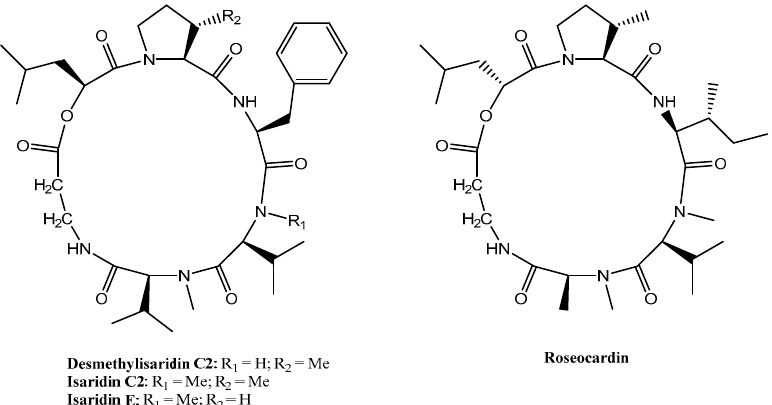
Figure 3. Structures of Desmethylisaridin C2, isaridin E, isaridin C2 and roseocardin. Table 1. IC 50 values of Desmethylisaridin C2, Isaridin E, Isaridin C2 and Roseocardin in vitro on